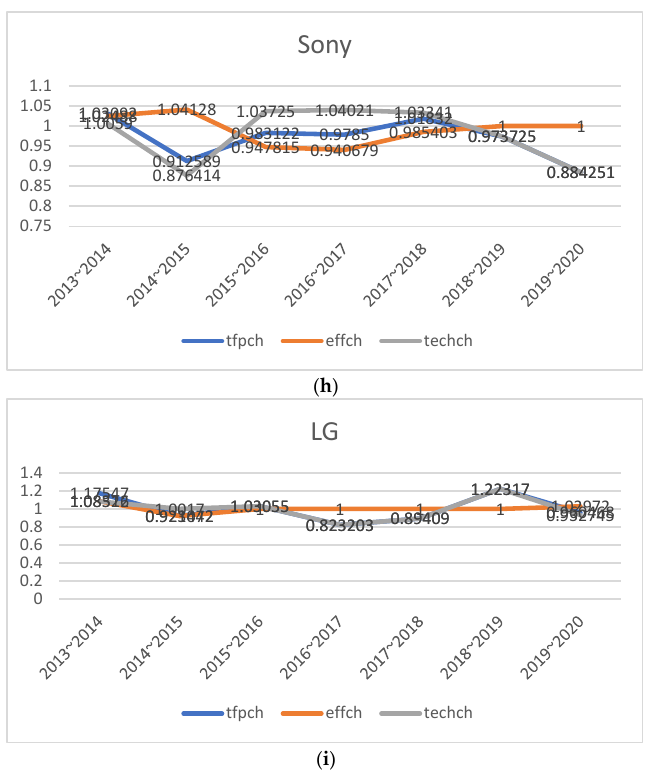
Figure 4. Dynamics of efficiency and technology changes: ( a ) Xiaomi; ( b ) Oppo; ( c ) Vivo; ( d ) Huawei; ( e ) Samsung; ( f ) Apple; ( g ) Motorola; ( h ) Sony; ( i ) LG.